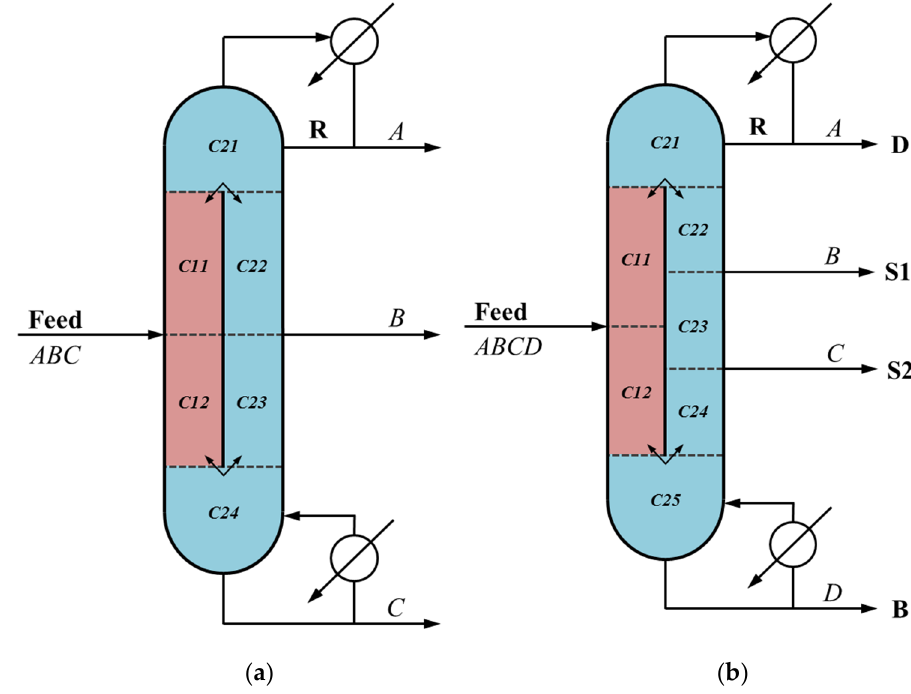
Figure 1. Two sorts of dividing-wall distillation columns (DWDCs): ( a ) Conventional three-component DWDC; ( b ) Kaibel distillation column.